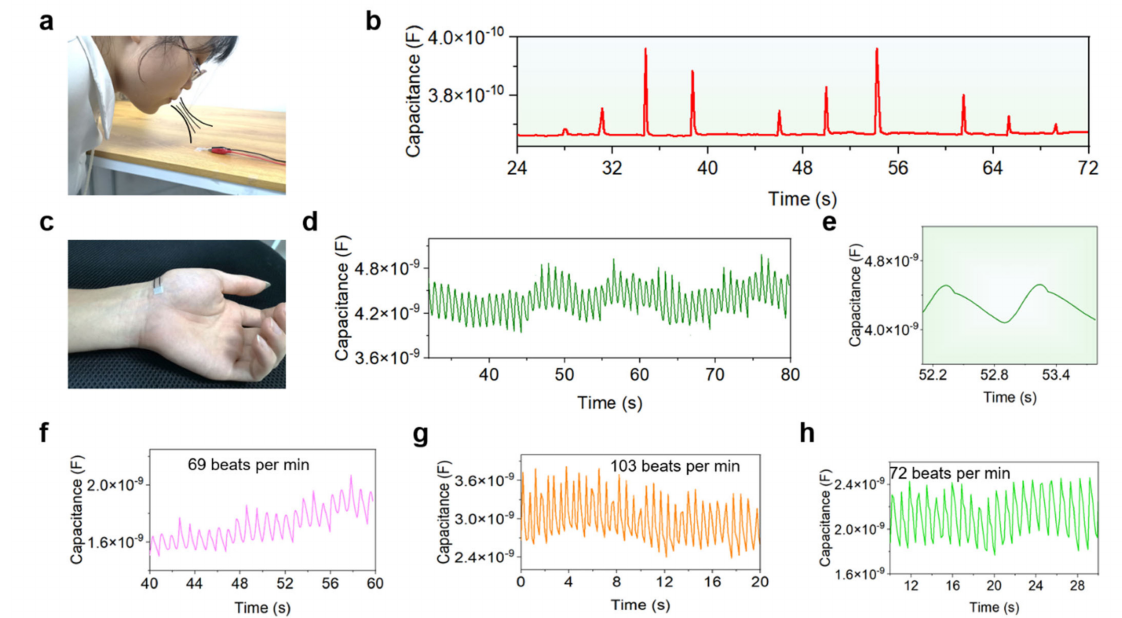
Figure 6. Monitoring of physiological signals and activities based on the flexible iontronic pressure sensors. ( a ) Digital picture showing that a subject is blowing air of different intensities towards a sensor. ( b ) Response signals of the sensor to airflows with different intensities, indicating high sensitivity of the sensor. ( c ) Photograph showing a sensor mounted on the wrist of a subject for pulse signal monitoring. ( d , e ) Continuously recorded pulse signals ( d ) and enlarged pulse waveforms ( e ) of the subject with the iontronic pressure sensor. ( f – h ) Pulse signals recorded at different physiological status,